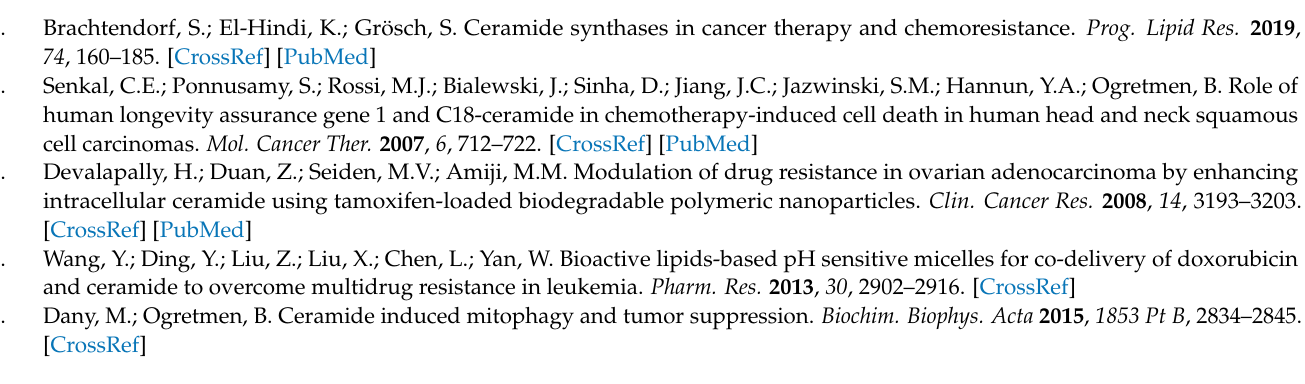
Figure S2: Volcano plot analysis. Figure S3: Gene canonical pathway analysis. Figure S4: No effect of exercise on sphingosine. Figure S5: Uncropped blots. Table S1: Genes/antibodies in RPPA. Table S2: Significant genes/antibodies showed up/downregulation by exercise/doxorubicin treatment in RPPA. Table S3: Enriched canonical pathways in IPA. Table S4: Absolute concentration of ceramide species (pmol/mg) in BP melanoma